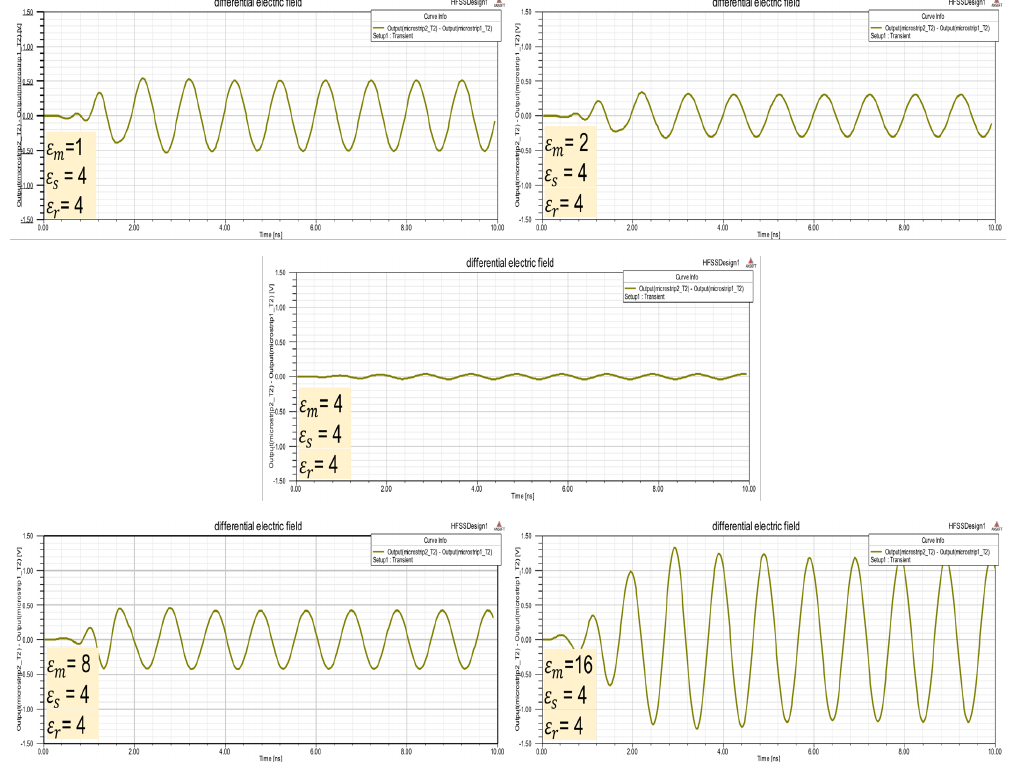
Figure 13. Microstrip line simulation with reference and substrate permittivity (cid:101) r = 4. Different permittivity medium (cid:101) m are used to obtain differential electric field on microstrip